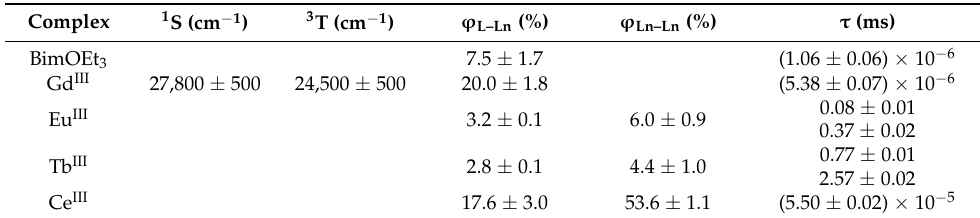
BimOEt 3 is triethyl 2,2 (cid:48) ,2 (cid:48)(cid:48) (2,2 (cid:48) ,2 (cid:48)(cid:48) nitrilotris(methylene) tris (1 H -benzimidazole-2,1-diyl))